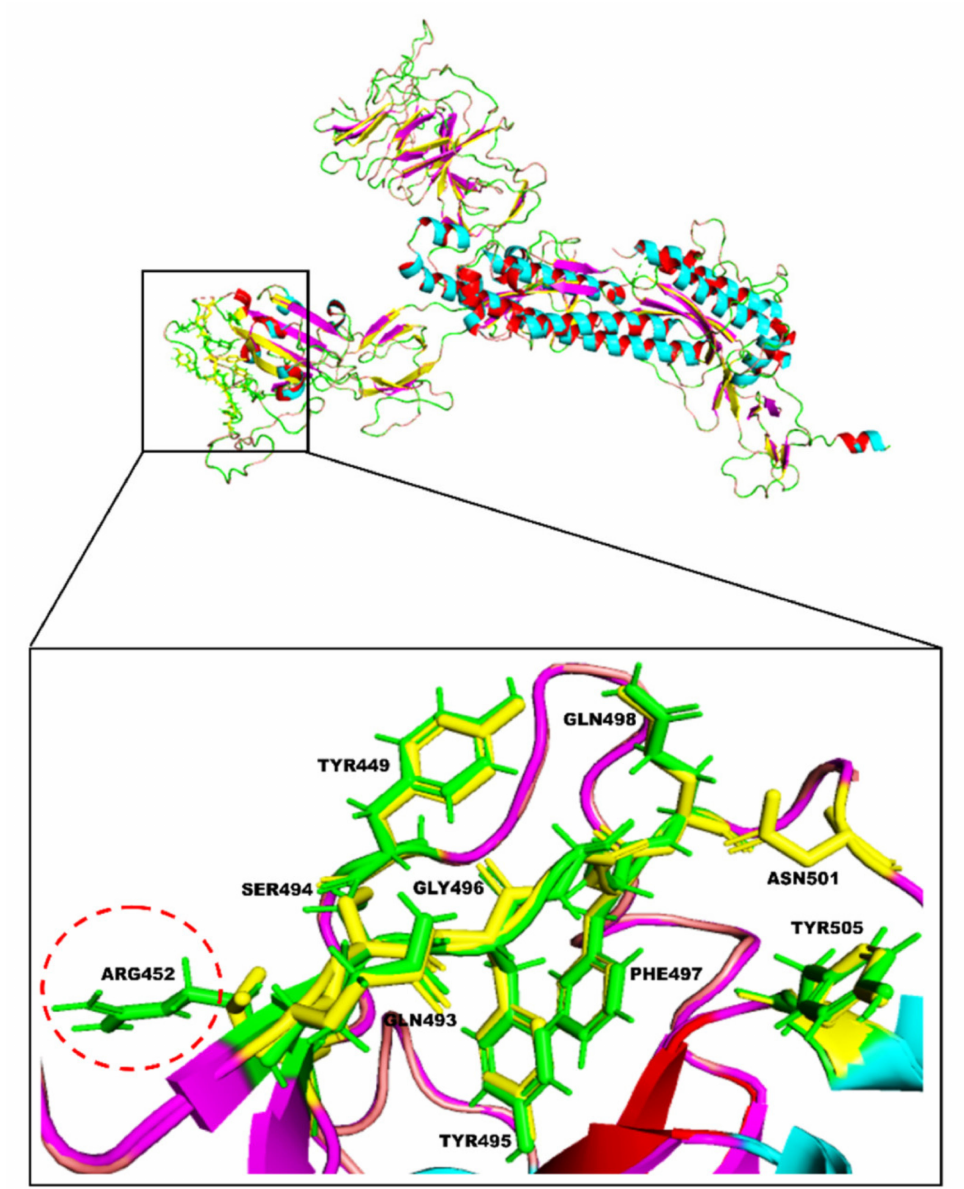
Figure 2. Superimposed 3D structures representing the spike RBD region of wild-type (yellow) and Delta (green) SARS-CoV-2 strains with their active site residues highlighted. L452R (substitution in Delta) and N501Y (substitution present only in wild-type) are the two mutations reported in the RBD region of the two